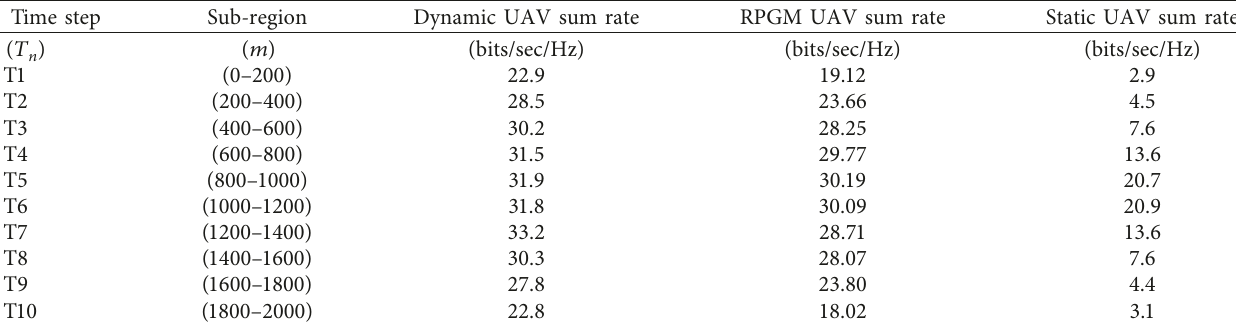
Table 3: Average sum rate for dynamic and static UAV